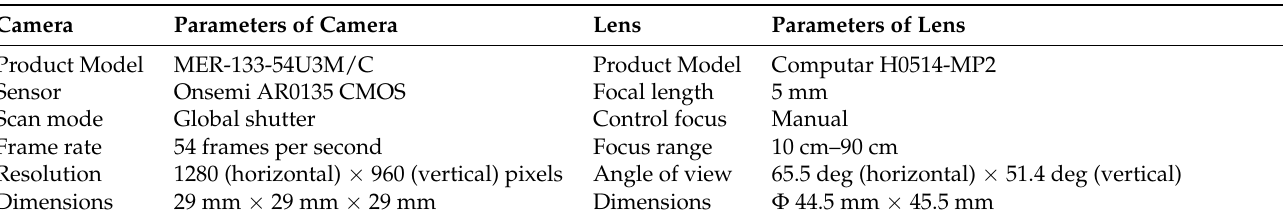
Table 1. Specifications of the camera and